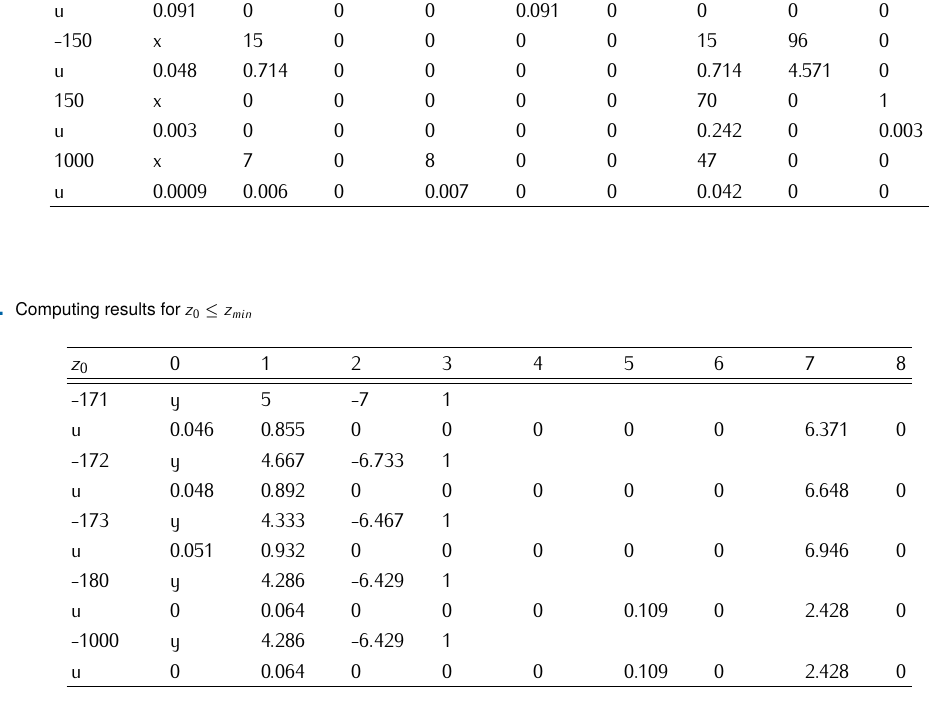
Table 1. Computing results for z